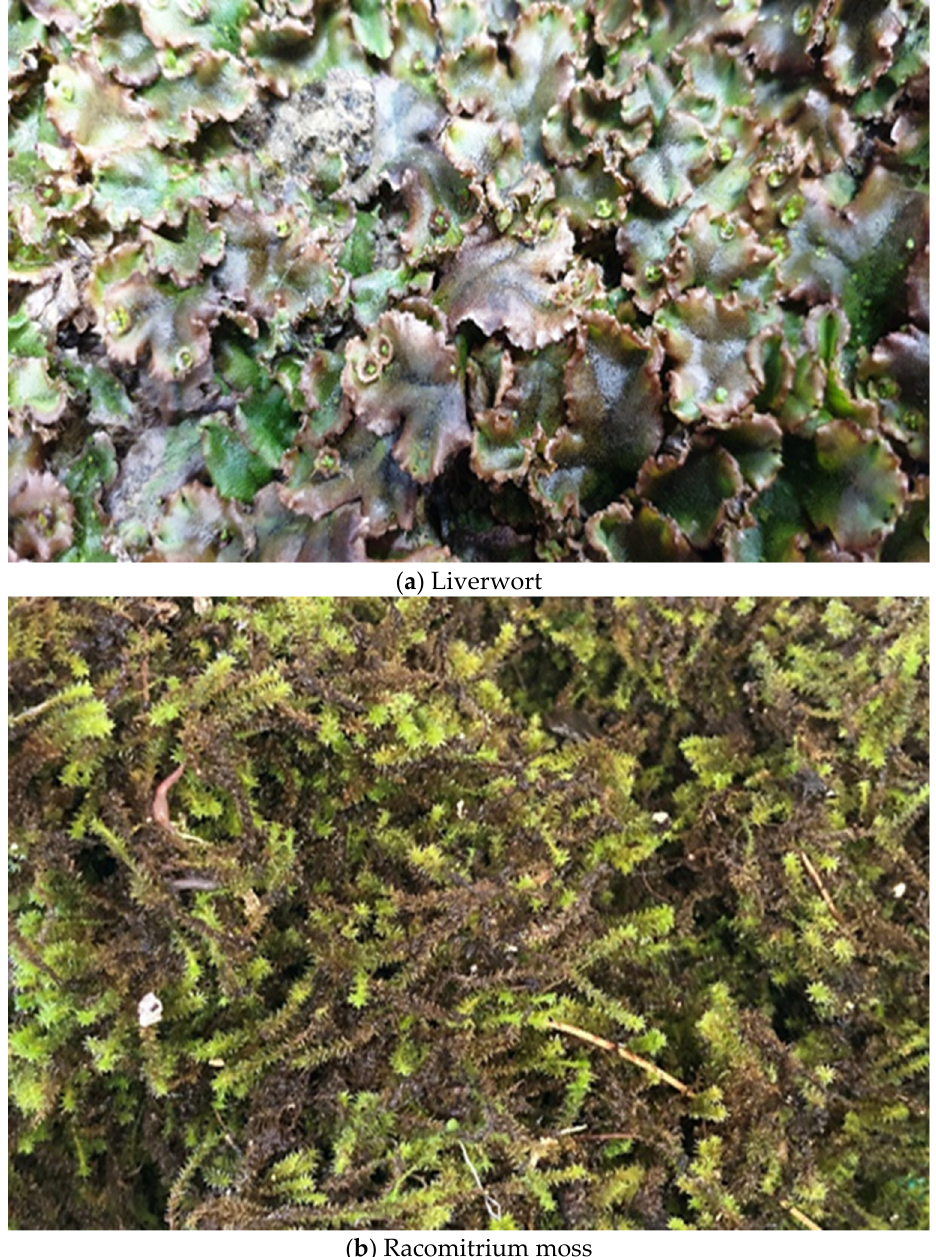
Figure 1. Morphology of liverwort and Racomitrium moss.